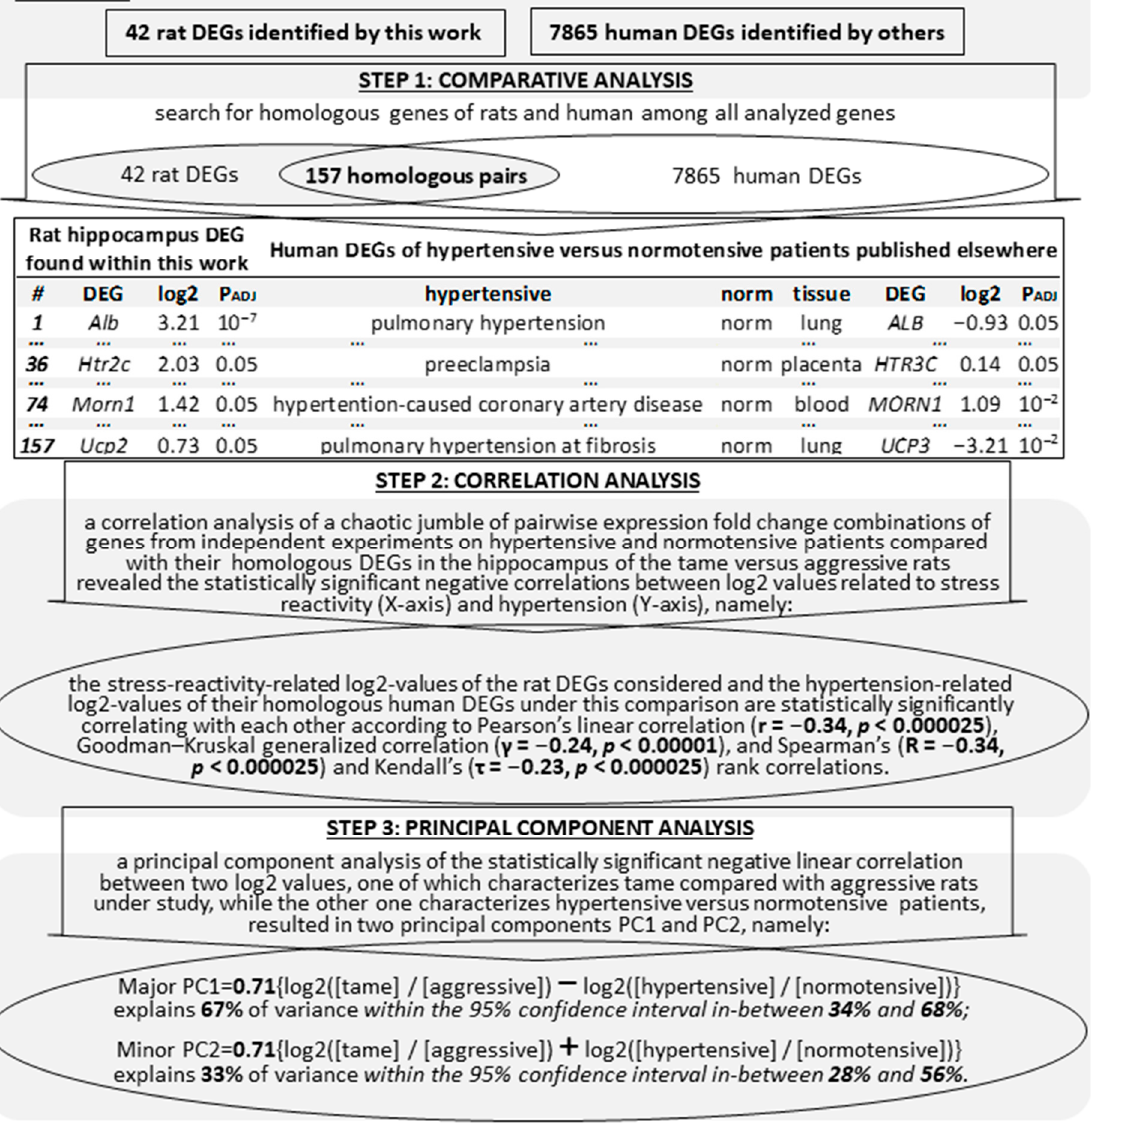
Figure 2. A step-by-step diagram of verification of the obtained results on the hypertensive versus normotensive animals examined in this work with respect to all the transcriptomes (that we could find) of hypertensive versus normotensive patients (Table 5). Legend : see the footnote of Table 2; PC1 and PC2: principal components calculated using the PAST4.04 software [77].